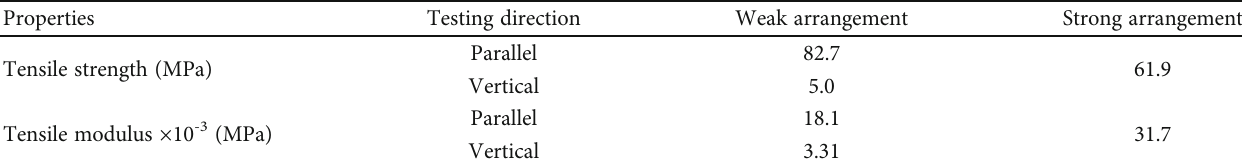
Table 4: Performance of high silica/phenolic